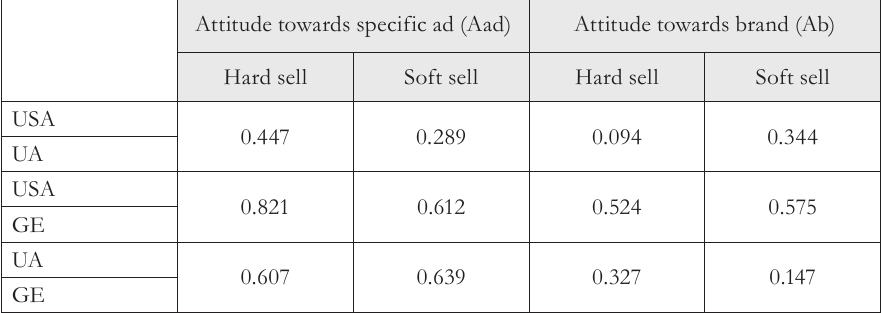
Tab. 9 - Attitude towards specific ad (Aad) and attitude towards brand (Ab). Source: authors’